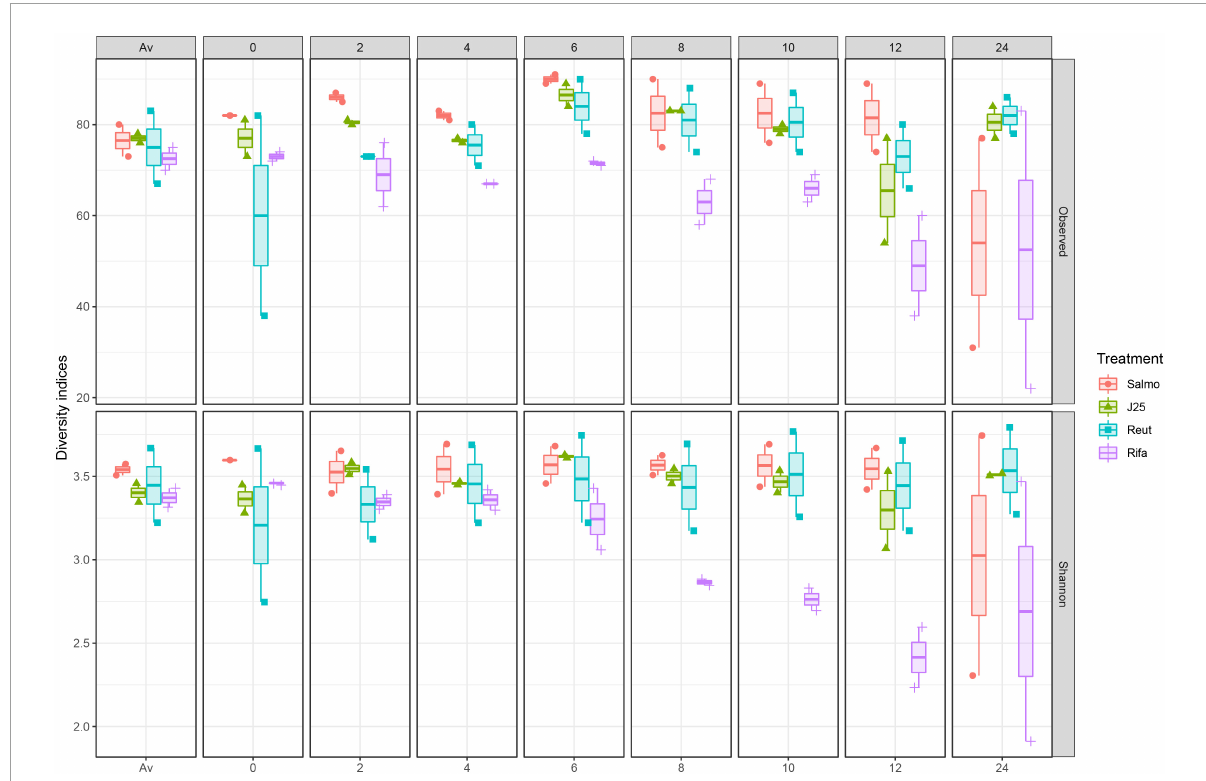
FIGURE3 Impact of Salmonella Newport alone (Salmo) and in combination with MccJ25 (J25), reuterin (Reut) or rifampicin (Rifa) on the porcine intestinal microbiota in vitro as measured by 16S rRNA gene amplicon sequencing. Alpha diversity measured by Shannon index (Shannon) and number of Observed ASVs (Observed) at each fermentation day: Av (before treatment), 0, 2, 4, 6, 8, 10, 12, and 24. Per each treatment and time point, two independent replicates are